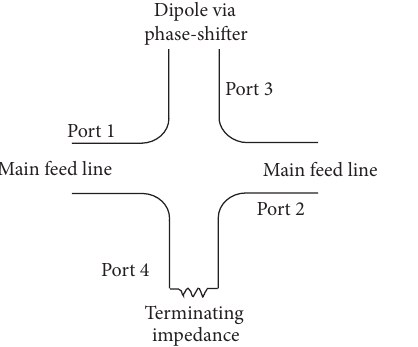
Figure5:Schematicofafour-portcoupleroftheseriesfeednetwork in phased array.